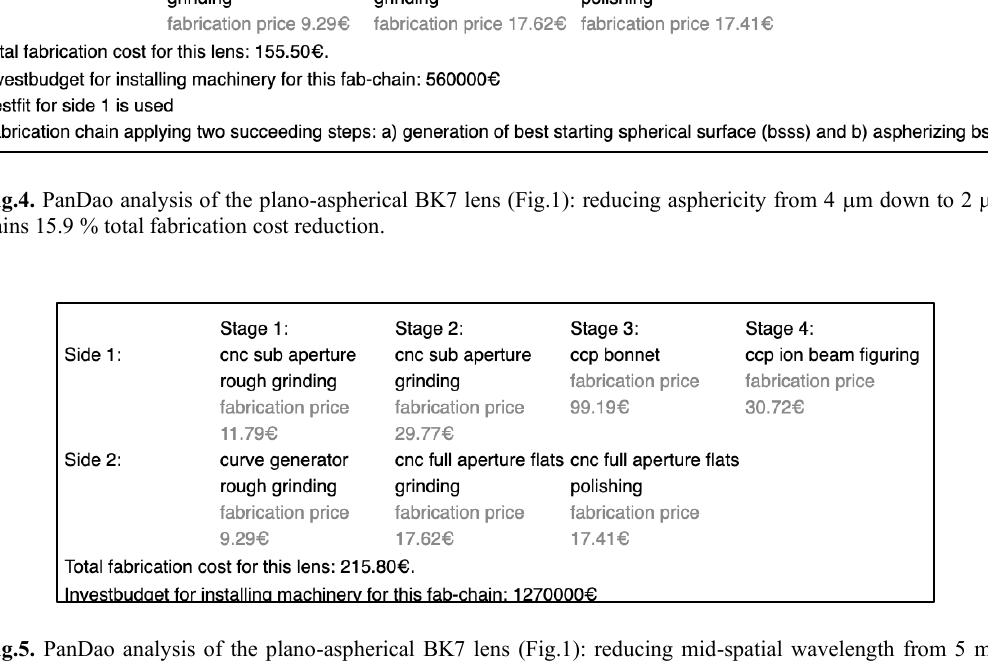
Fig.5. PanDao analysis of the plano-aspherical BK7 lens (Fig.1): reducing mid-spatial wavelength from 5 mm down to 0,2 mm generates 16.6 % more fabrication